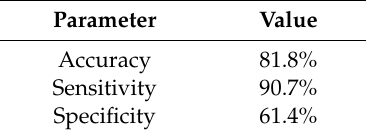
Table 3. Achieved parameters of the gas analytical